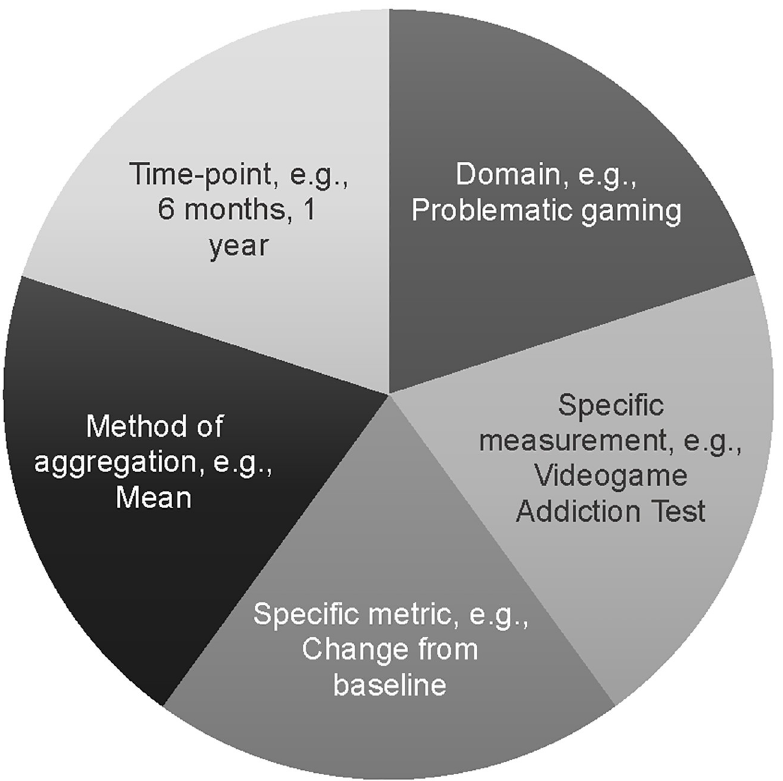
Fig 1. Defining outcomes for a systematic review or meta-analysis. Elements of outcome domains required for complete outcome specification in health research. Figure adapted from [15]; see also the PRISMA-P [16] statement or description of PICOS